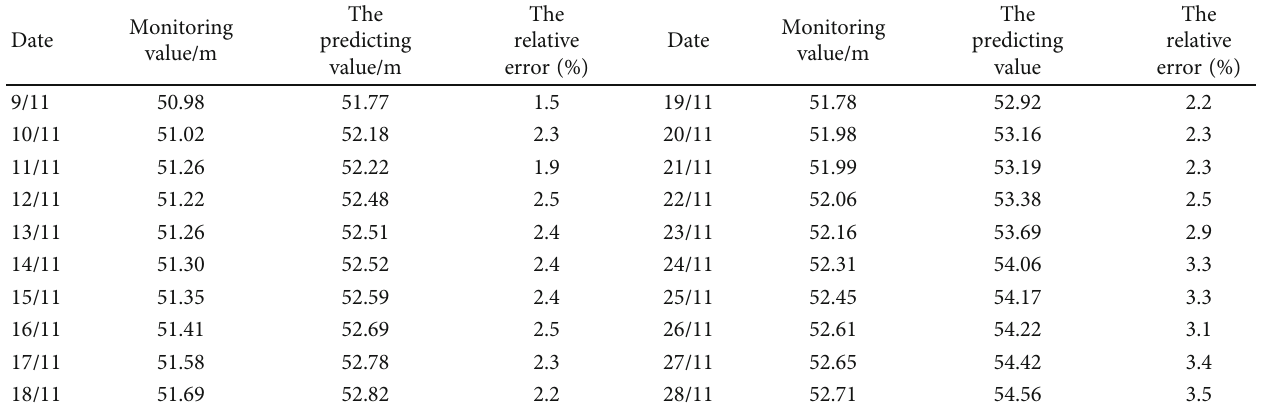
Table 2: The comparison of errors between the monitoring datum and predicting